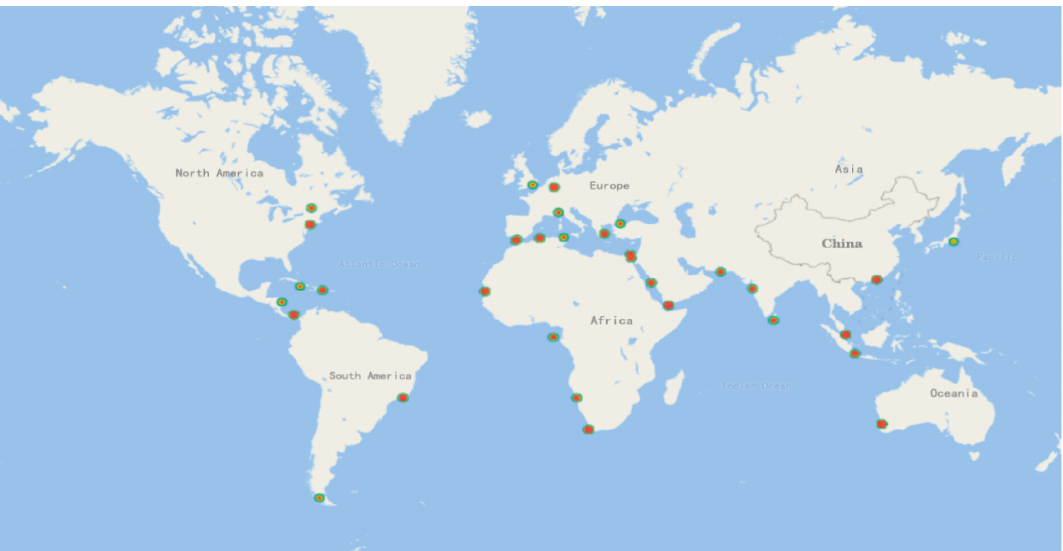
Figure 4: The thermodynamic diagram about rank in the top 34 ports in the betweenness centrality.